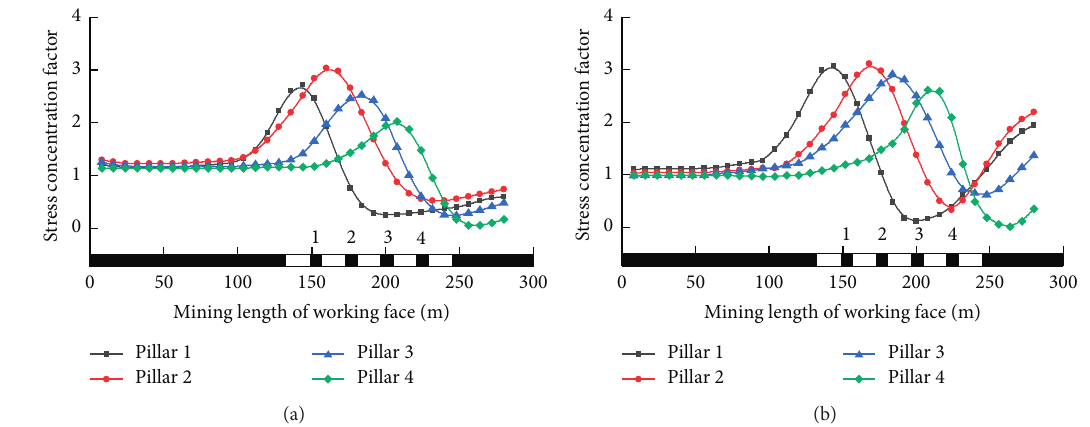
Figure 8: Stress evolution in coal pillars with different